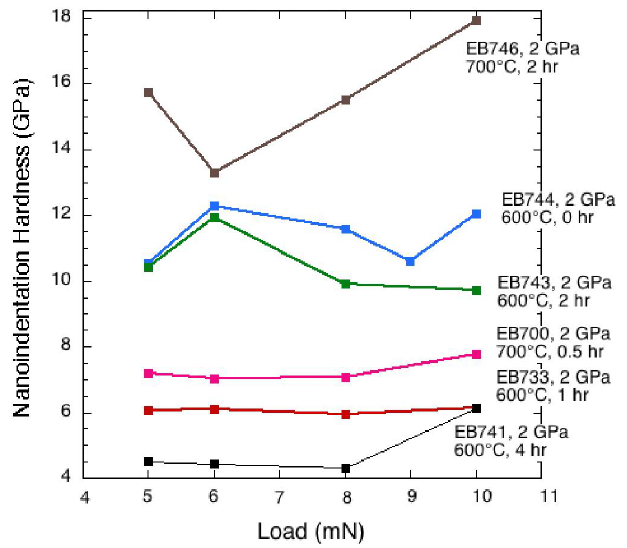
Figure 4. Nanoindentation results for hardness of Ti samples for loads ranging between 5–10 mN.